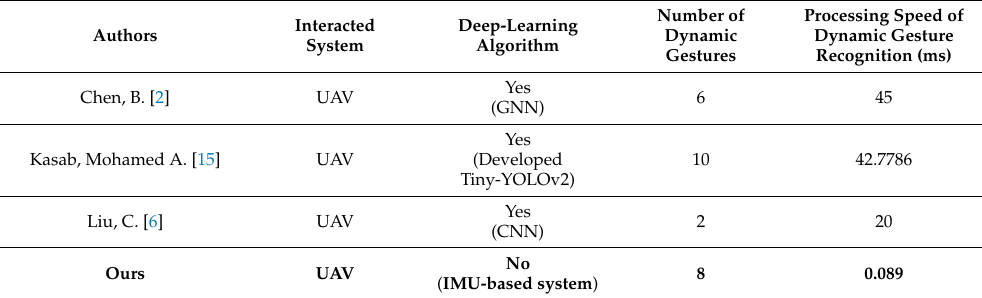
Table 5. Result of comparison between the proposed system and the vision-based system for dynamic gesture recognition.